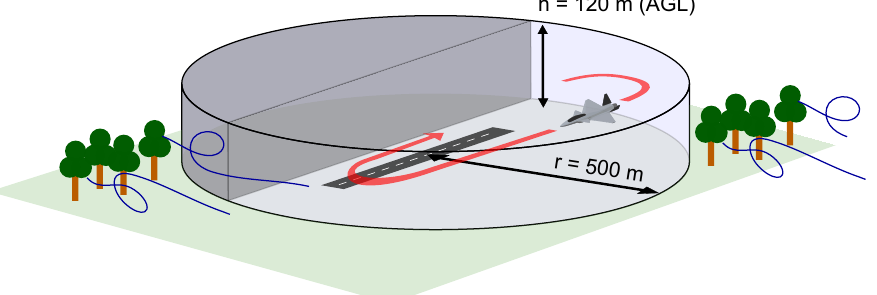
Figure 5. Typical airspace available for flight testing within VLOS (levels 1 and 2 in Table 5): a challenging environment with severe exposure to ground